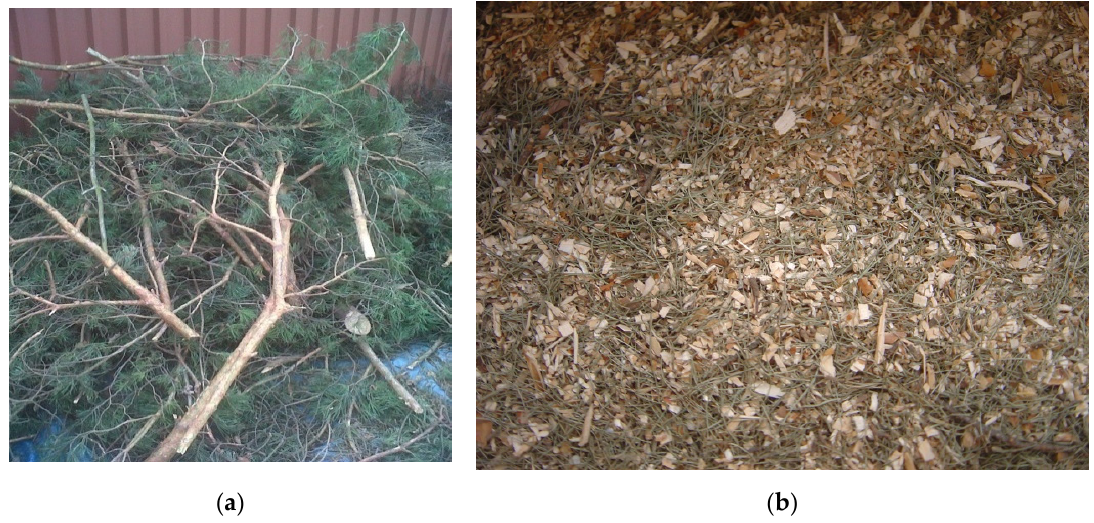
Figure 1. Scots pine ( Pinus sylvestris L.) forest residues: ( a ) natural state; ( b ) after shredding.